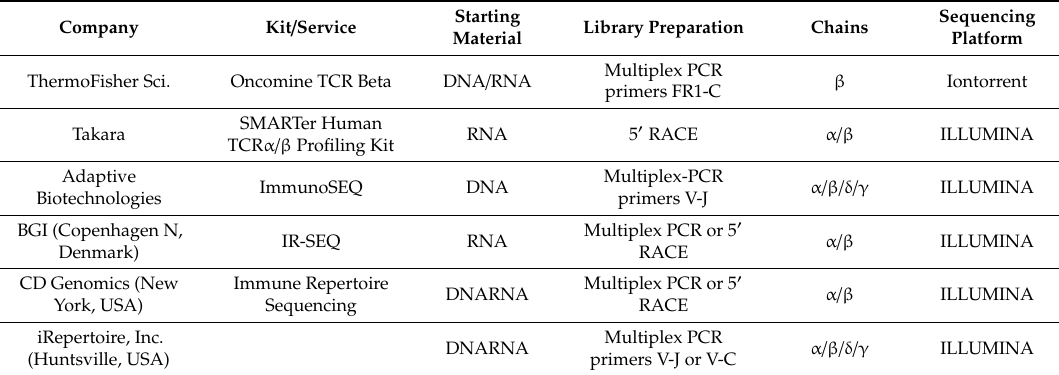
Table 1. Non-exhaustive list of companies providing immune repertoire products and